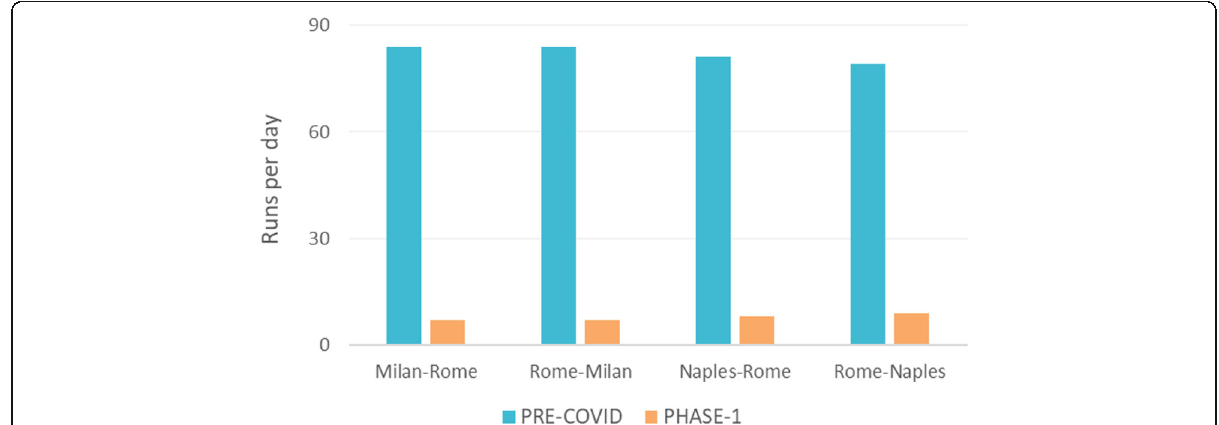
Fig. 7 Comparison of runs per day between the PRE-COVID and the PHASE-1 scenario for the different origin-destination pairs under